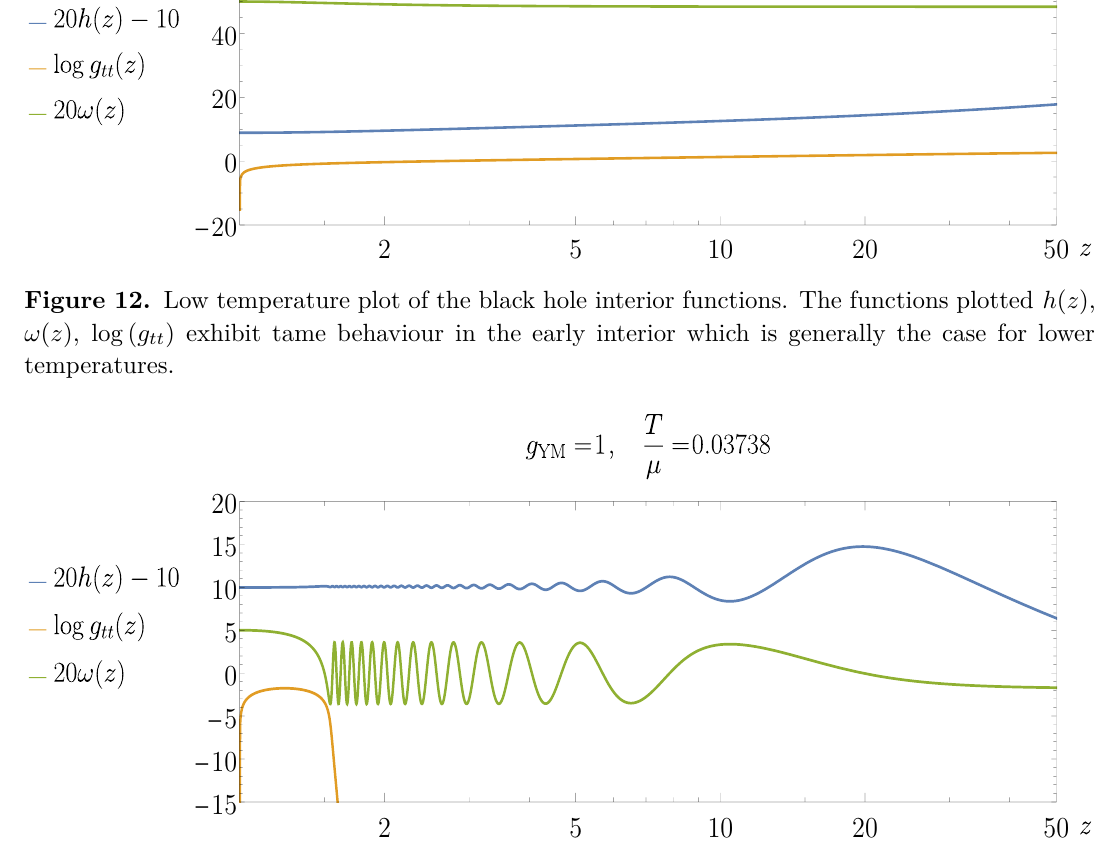
Figure 13. High temperature plot of the black hole interior functions. Far more interesting phenomena emerge for functions h ( z ) , ω ( z ) , log ( g tt ) , when close to critical temperature. Here we identify the Josephson oscillations of condensate function ω ( z ) , while the large decrease in log ( g tt ) at z ≈ 1 . 5 is known as the collapse of the Einstein-Rosen